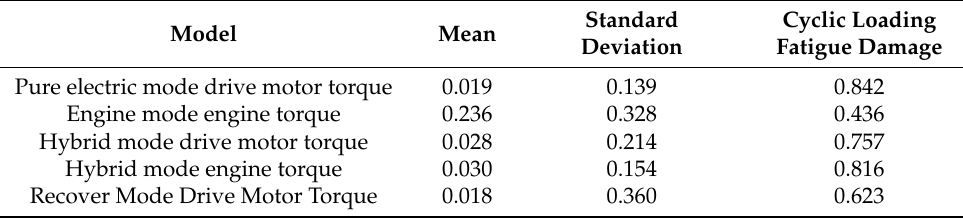
Table 3. Objective weight coefficients of the five working mode data.